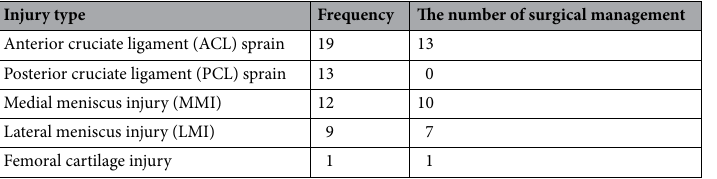
Table 3. List of a previous history of a traumatic knee joint injury. The number of participants who sustained multiple knee joint injury: ACL + MMI = 4, ACL + LMI = 2, MMI + LMI = 4, LMI + cartilage = 1.